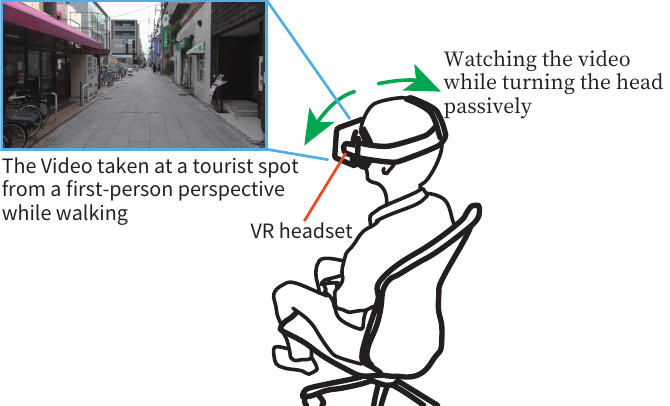
Figure 1. Image of a user watching a video while experiencing head movements corresponding to